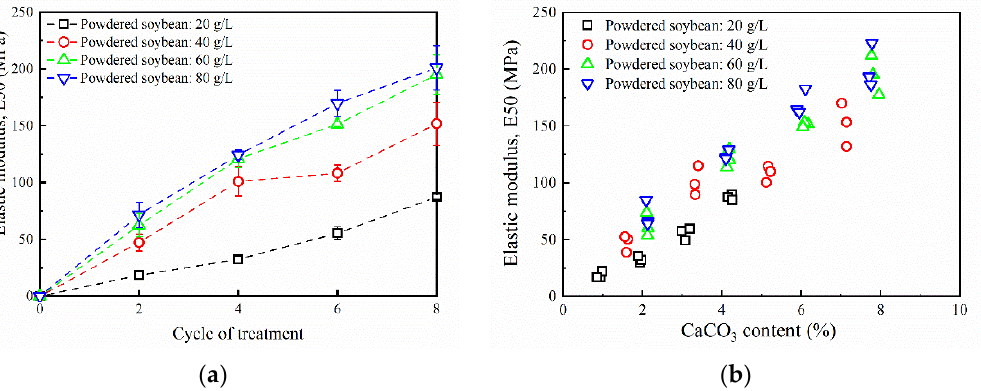
Figure 13. Effect of powdered soybean concentration on E50 as a function of ( a ) cycle of treatment and ( b ) CaCO 3 content.